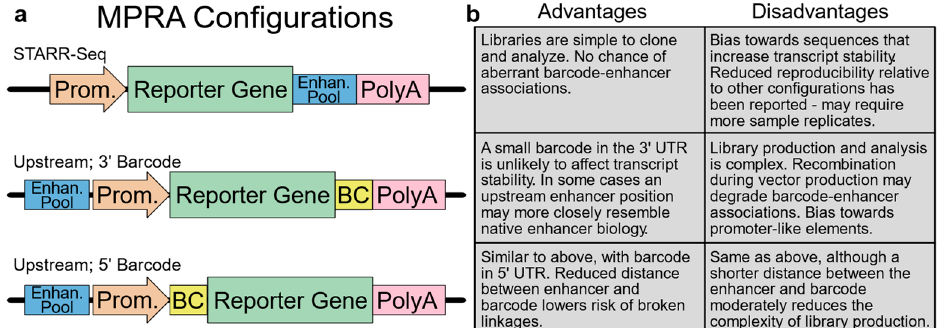
Figure 2. Comparison of different MPRA strategies. ( a ) Common MPRA configurations. ( b ) Strengths and weaknesses of each configuration. Prom., minimal promoter; Enhan. Pool, pool of candidate enhancers; BC, barcode.